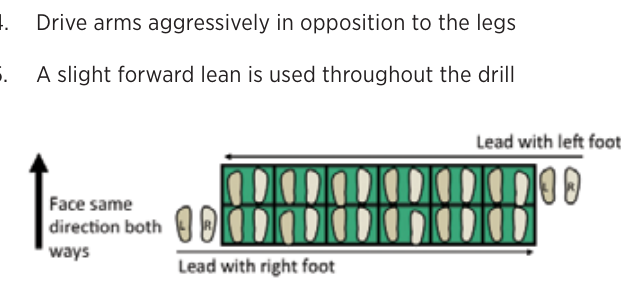
Figure 5-25. Rope or Ladder Routine – Lateral Step